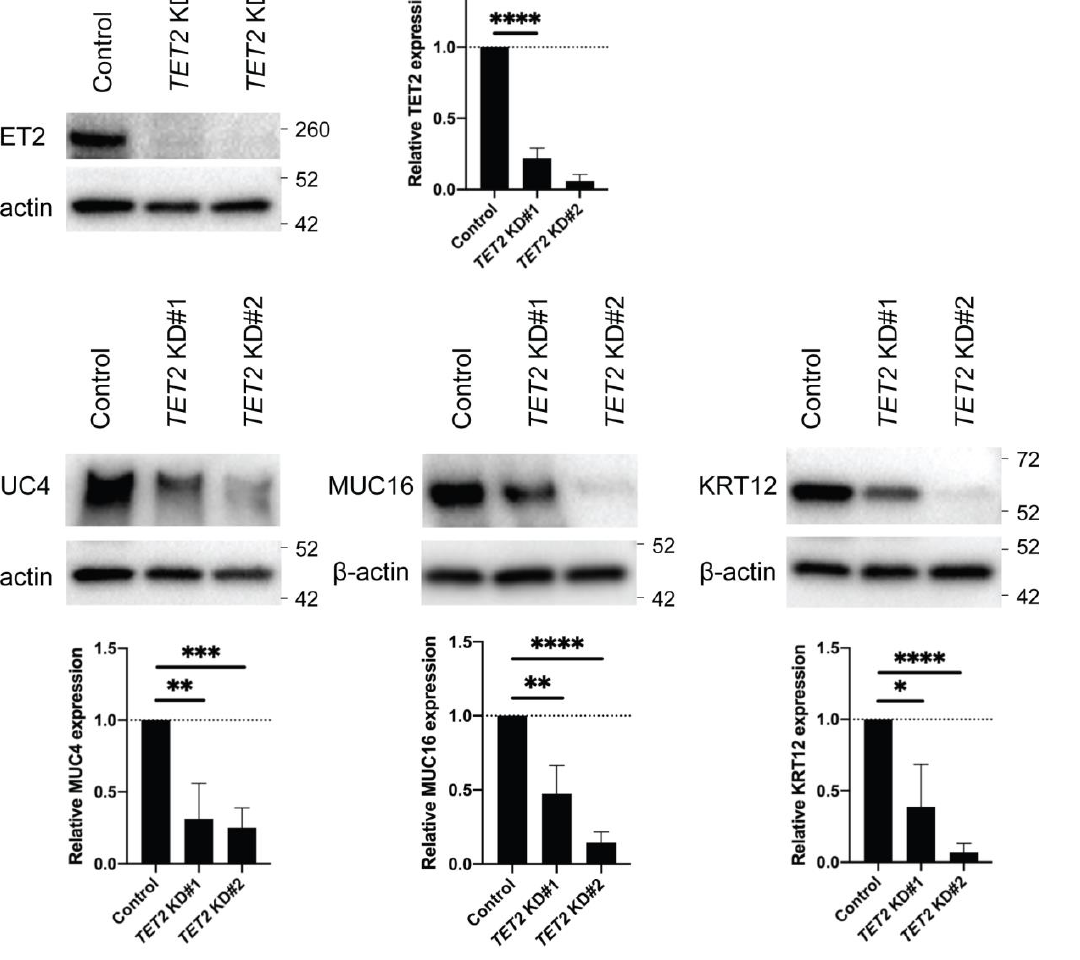
Figure 2. Expression of corneal differentiation genes in TET2 KD cultured corneal epithelial cells. ( A ) Left, Western blot analyses of TET2 protein expression in TET2 KD cells. Right, bar graphs represent the quantitative analyses of TET2 protein expression ( TET2 KD#1: 21.6 ± 7.2%, TET2 ± KD#2: 5.8 ± 4.7%, n = 5; **** p < 0.0001). Data were analyzed using a Tukey’s multiple comparisons test. ( B ) Top, Western blot analyses of MUC4, MUC16 and KRT12 expression in TET2 KD cells. Bottom, bar graphs represent the quantitative analyses of expressions of MUC4, MUC16, and KRT12 protein ( TET2 KD#1: 31.3 ± 24.7%, TET2 ± KD#2: 25.1 ± 13.9% for MUC4, TET2 KD#1: 47.5 ± 19.0%, TET2 ± KD#2: 14.3 ± 7.3% for MUC16, TET2 KD#1: 38.8 ± 29.5%, TET2 ± KD#2: 7.0 ± 6.0% for KRT12; n = 5, * p < 0.05, ** p < 0.01, *** p < 0.001 and **** p < 0.0001). Data were analyzed using a Tukey’s multiple comparisons